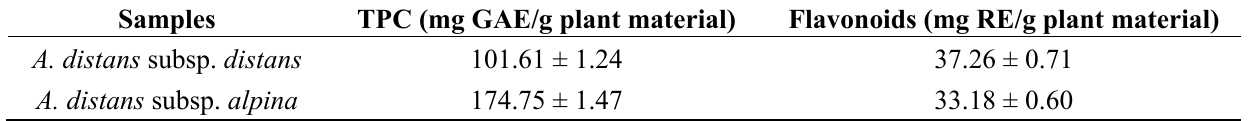
Table 3. The content of total polyphenols and flavonoids in A. distans extracts. Samples